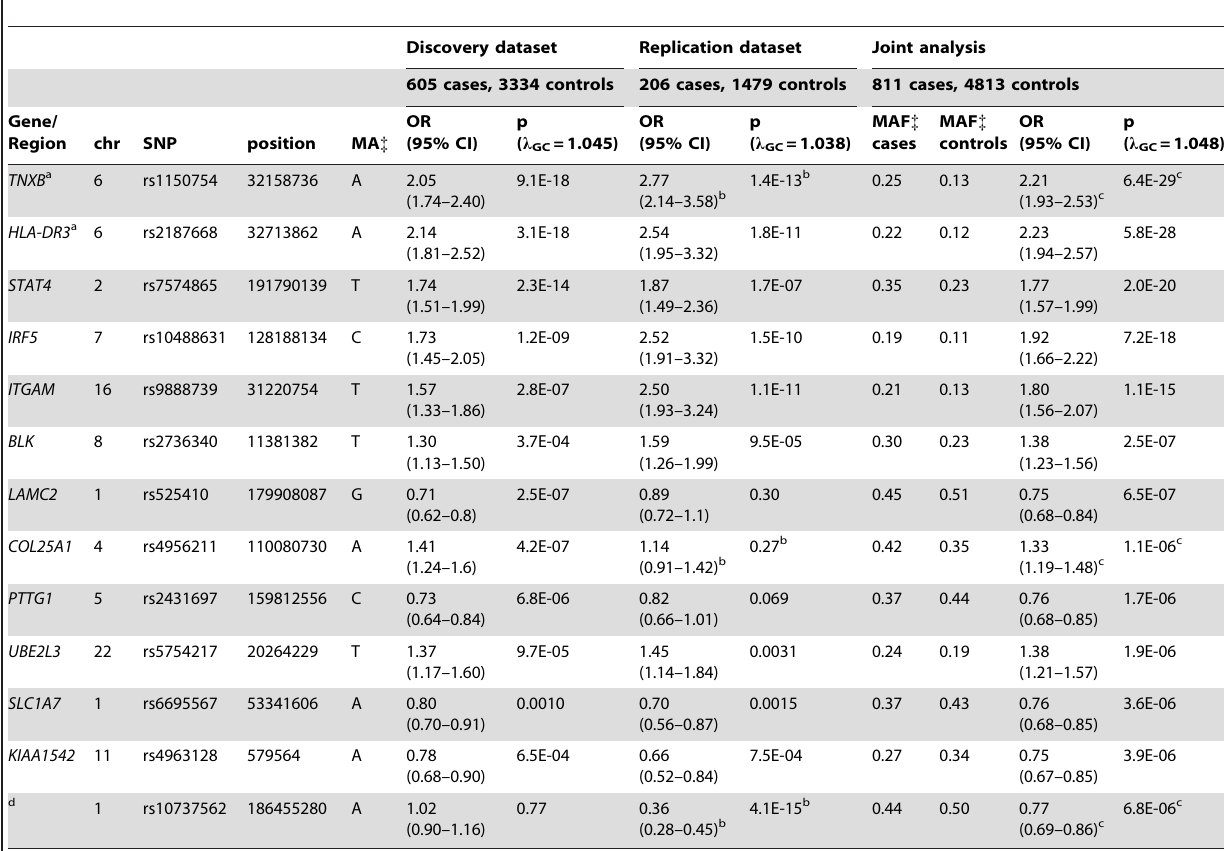
Table 2. Loci with significant (p , 5E-07) or suggestive (p between 5E-07 and 1E-05) evidence for association with anti–dsDNA + SLE identified in the joint